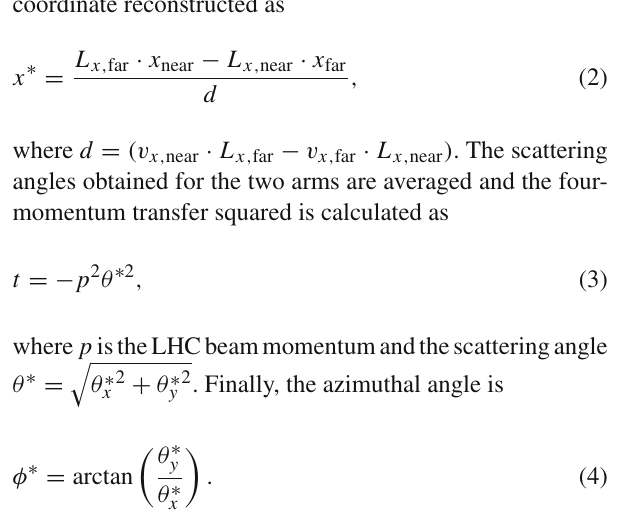
Fig. 1 Schematic layout of the LHC from IP5 up to the “near” and “far” Roman Pot units, where the near and far pots are indicated by full (red) dots on beams 1 and 2 coordinate reconstructed as